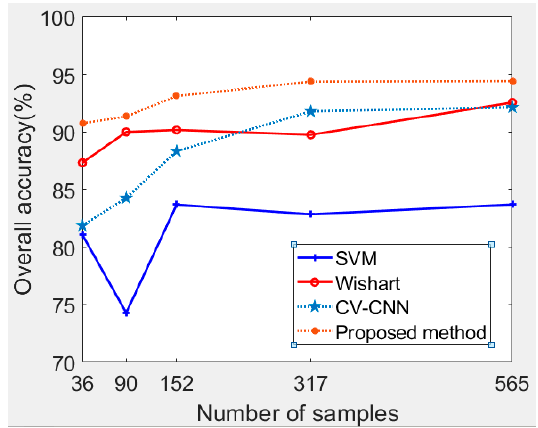
Figure 6. Trends of the OA with different numbers of training samples for the Flevoland dataset.